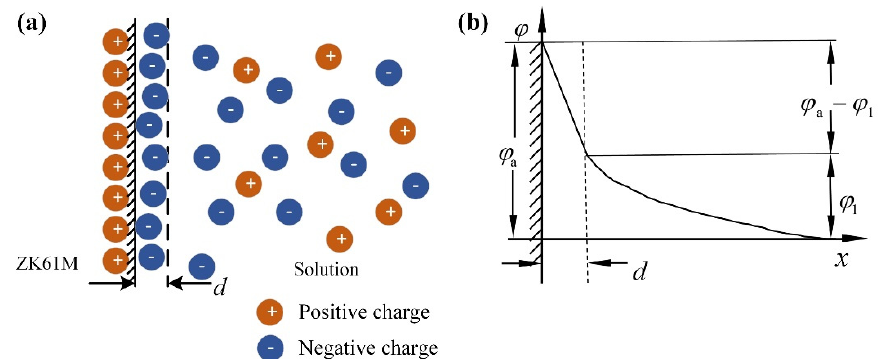
Figure 16. ( a ) Schematic diagram of ideal interface structure of ZK61M alloy/NaCl solution, ( b ) Schematic diagram of potential distribution as a function of interface distance.